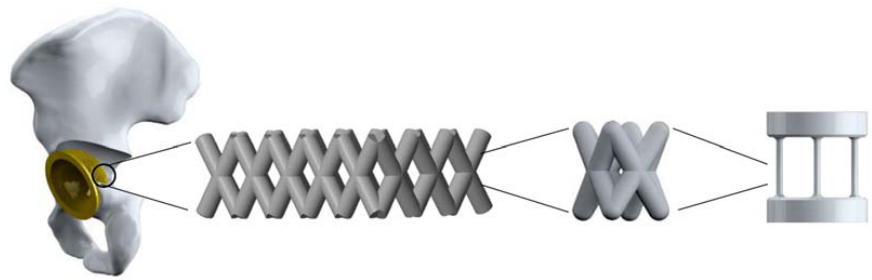
Figure 1. Exemplary representation of part of a pelvis with an acetabular cup. The surface is provided with a load bearing porous structure. The load bearing structure consists of a layer of repeating structural elements. The smallest element in any case is the rod.